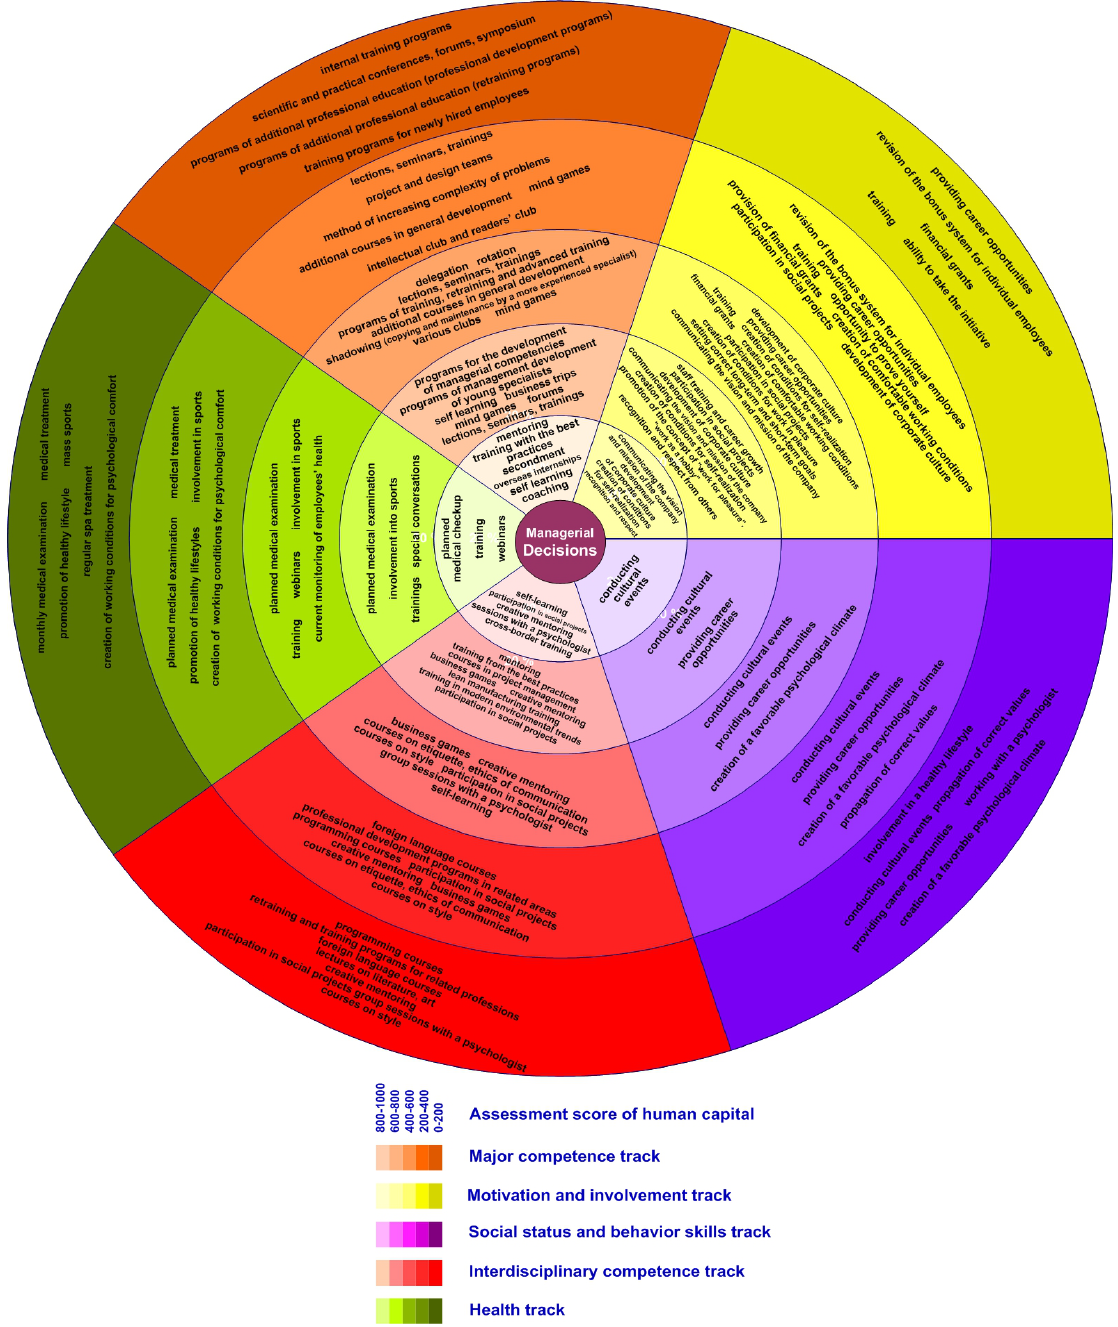
Figure 5. Management decision for human capital development by different tracks.